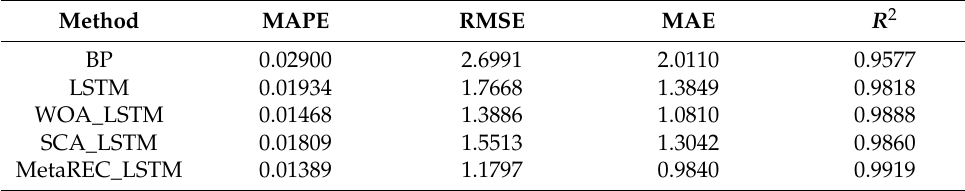
Table 6. Results of forecasting criteria evaluated by different methods.